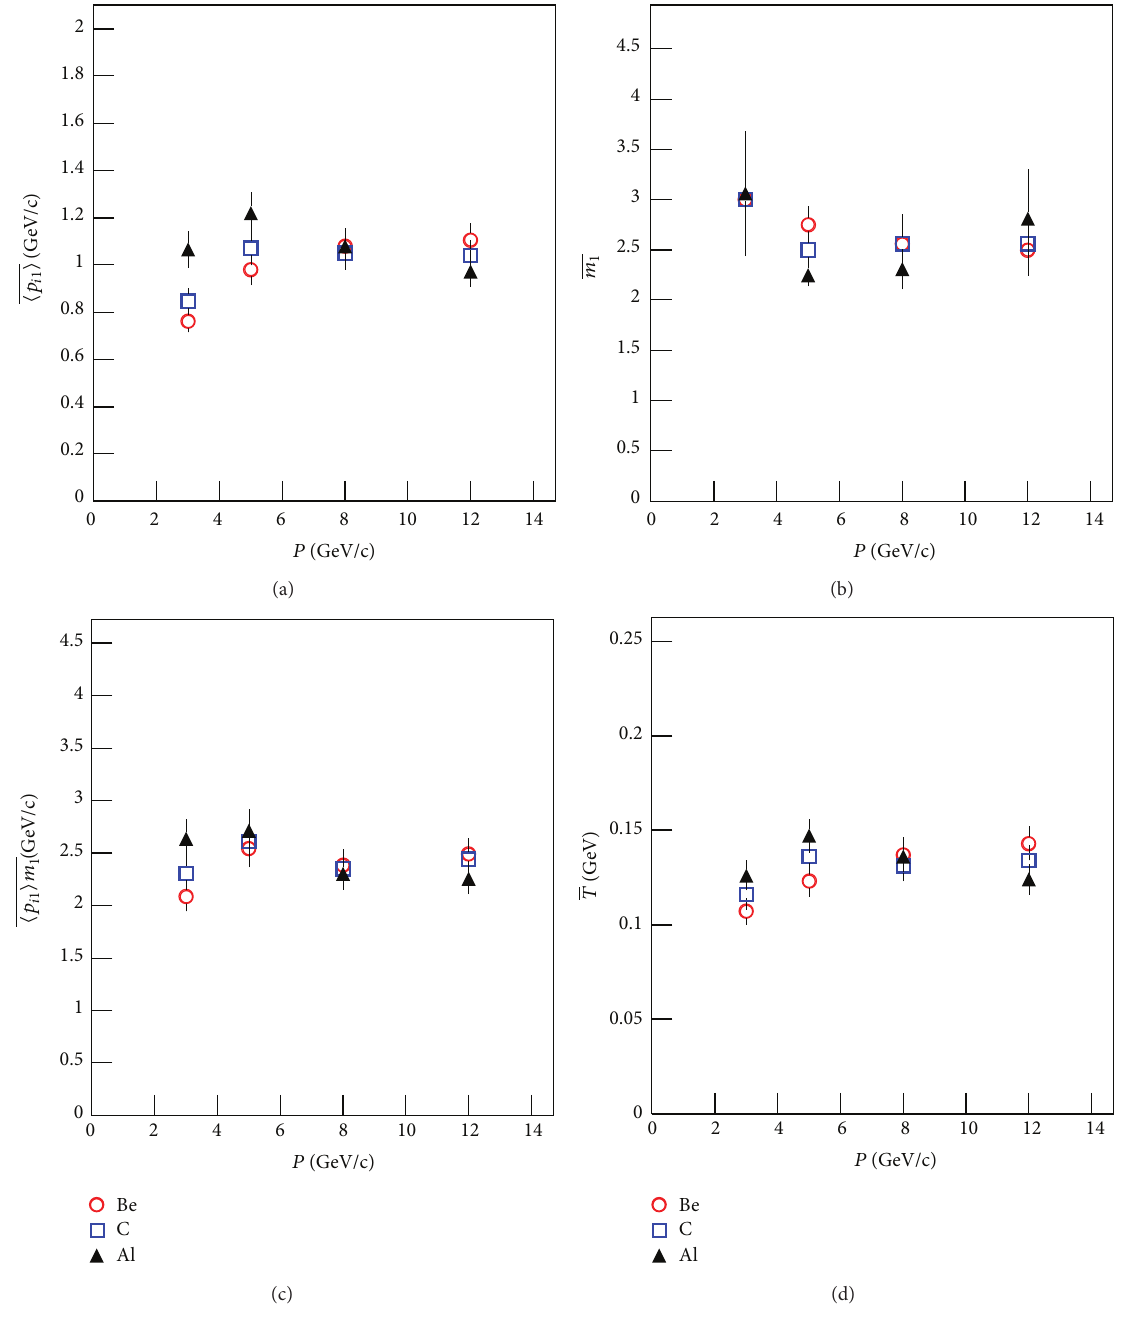
Figure 17: Dependences of (a) ⟨𝑝 𝑖1 ⟩ , (b) 𝑚 1 , (c) ⟨𝑝 𝑖1 ⟩𝑚 1 , and (d) 𝑇 on incident momentum 𝑃 for 𝜋 ± produced in 𝜋 ± induced reactions. The different symbols represent the corresponding values obtained for different targets. The original values of the concerned parameters are taken from Figures